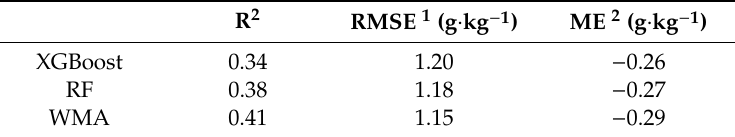
Table 2. Model diagnostics for independent validation.